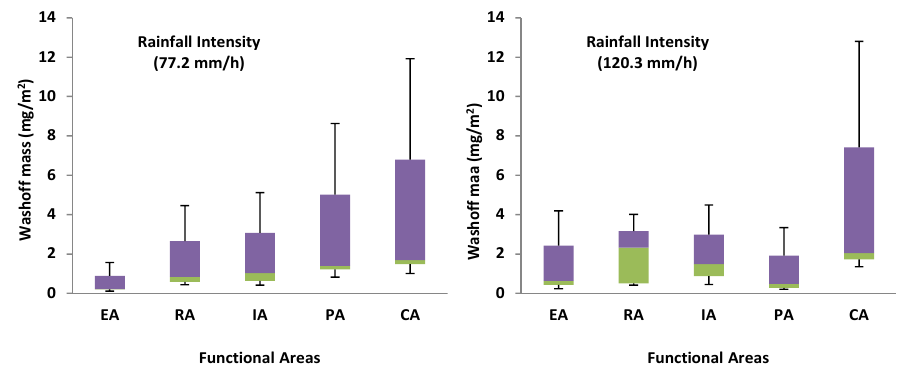
Figure 7. Box plots of the metal concentrations in the RDS in different functional areas.